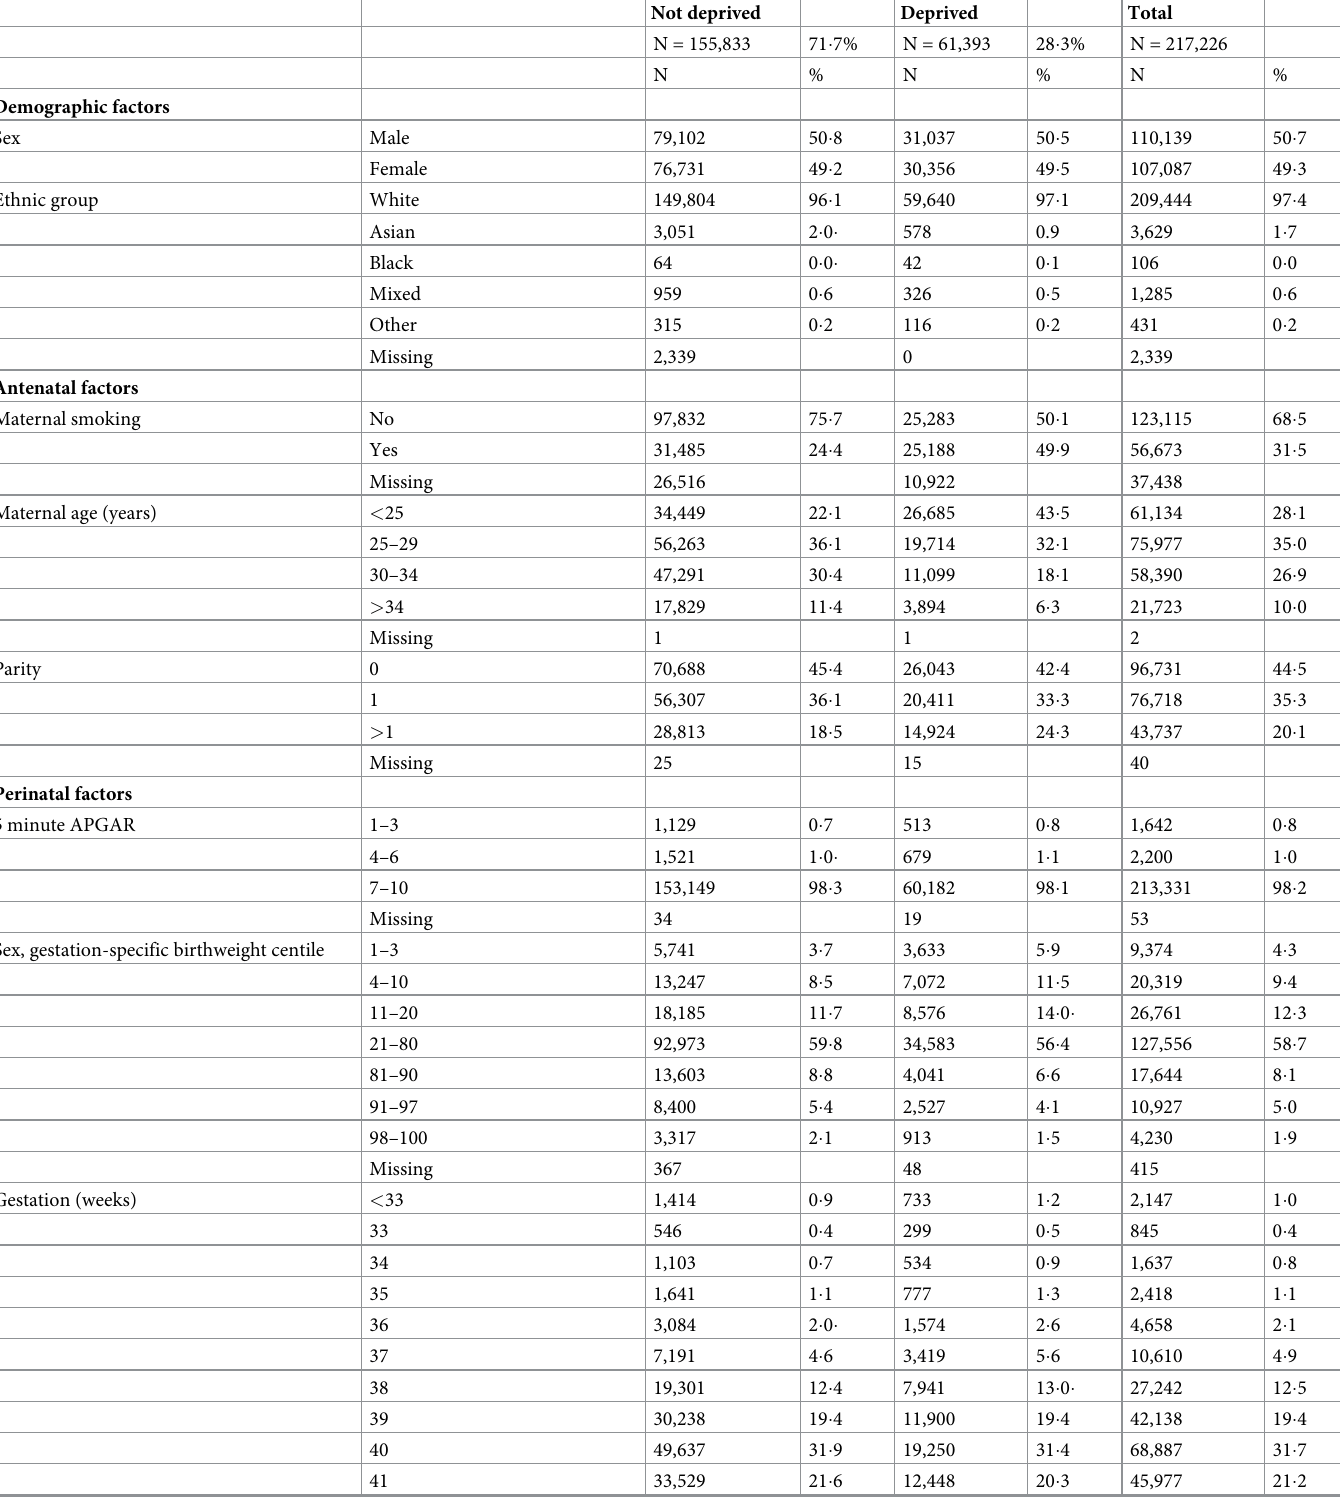
Table 1. Demographics of sample by deprivation